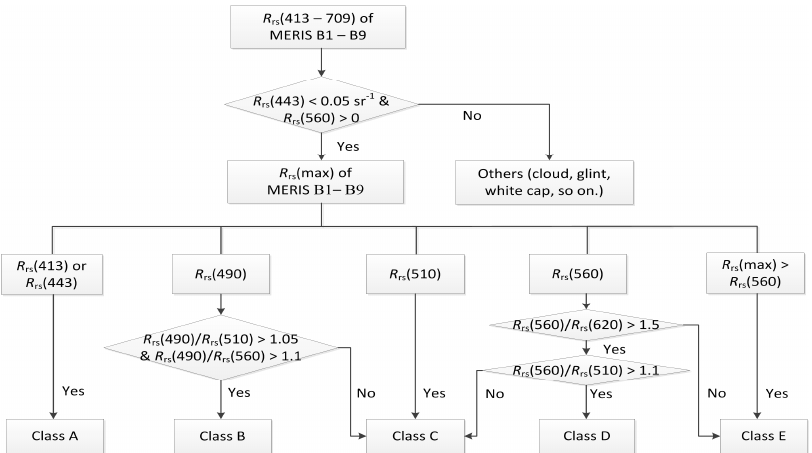
Figure 9. The classification tree used to categorize water masses into the five optical types (A–E) for MERIS data; the max is the wavelength where the peak of MERIS B1–B9 lies in.